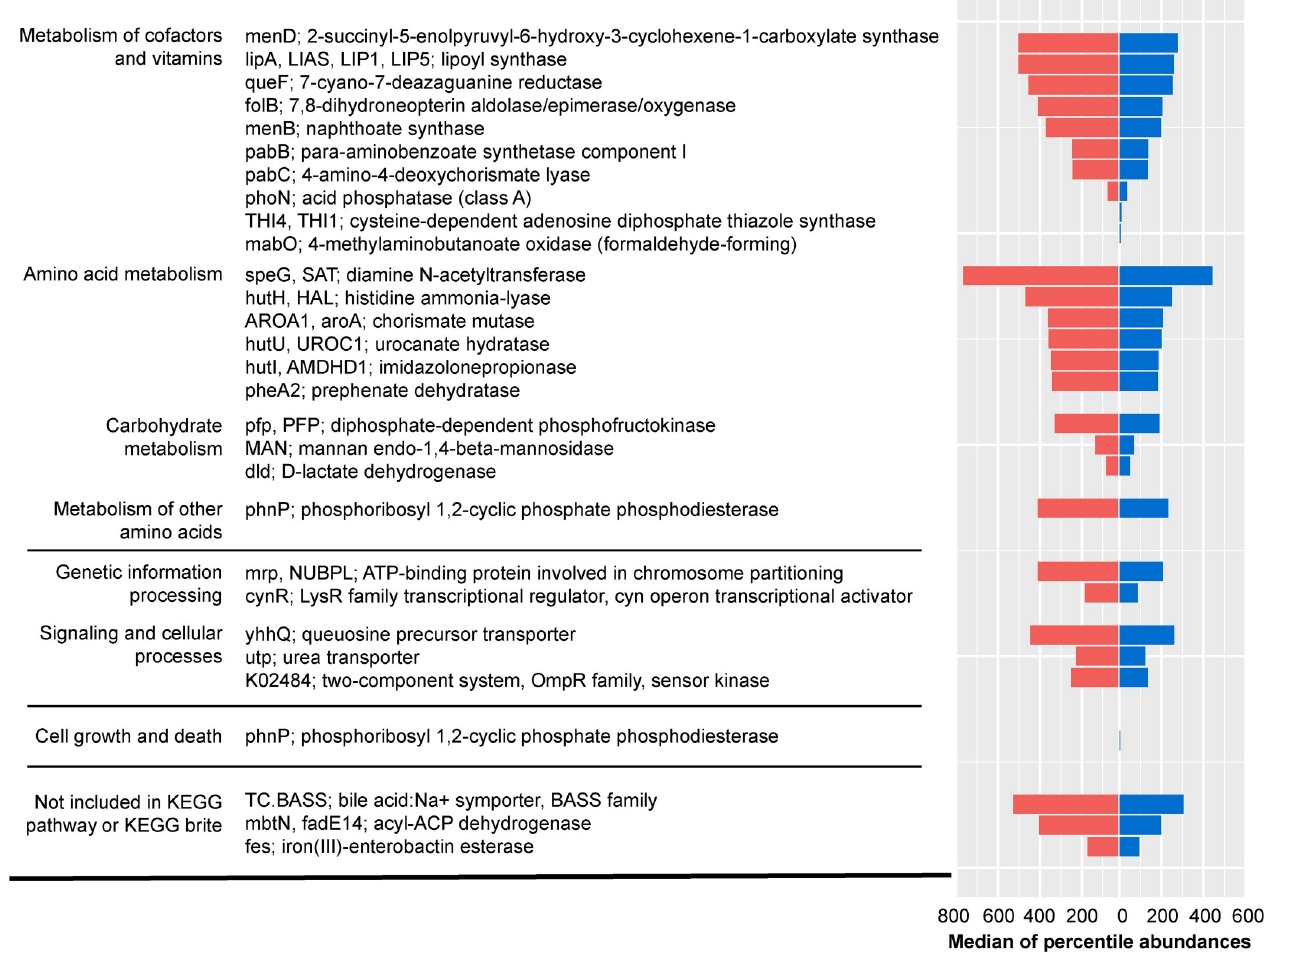
Fig 6. Pathways predicted to differ between LW and SC conditions. PICRUSt prediction results that focused on seasonal conditions of cecum microbiome in CBA/N mice. The left legend represents the KEGG pathways determined by ANCOM to be significantly different by seasonal condition (left; level 2, right; level 6). The bar graph on the right represents the median of percentile abundances each functional